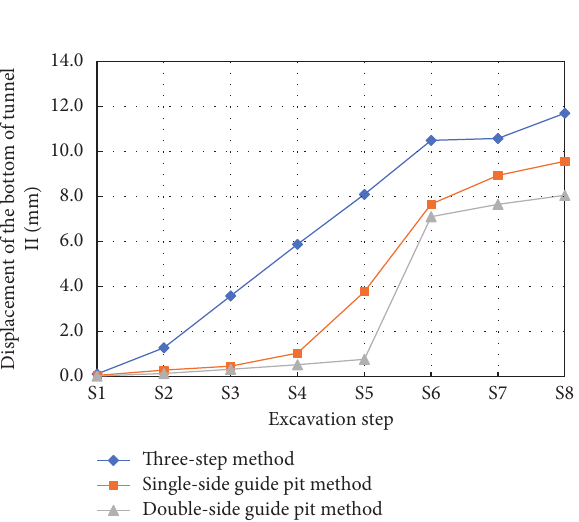
Figure 31: Displacement of the bottom of tunnel II.